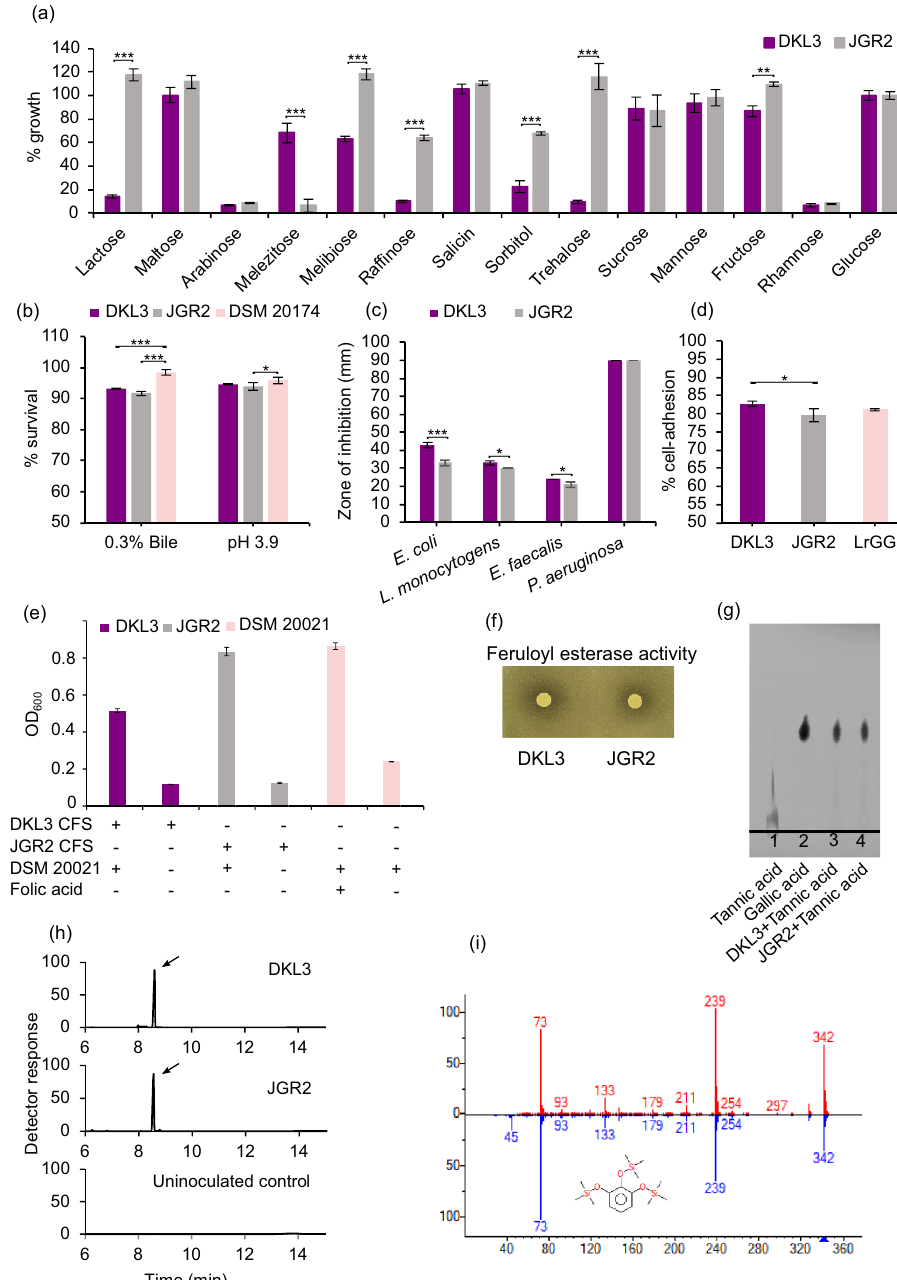
Figure 2. Phenotypic characterization of L. plantarum DKL3 and JGR2. ( a ) Sugar utilization. Values denoted are percentage as compared to glucose. ( b ) Bile and low pH survival. ( c ) Antimicrobial activity against various pathogens. ( d ) Adhesion to the HT-29 cell line. ( e ) Folate production as assessed by the growth of L. rhamnosus DSM 20021 in folic acid deficient medium supplemented with cell-free supernatant (CFS) of DKL3 and JGR2. ( f ) Feruloyl esterase activity as seen as the zone of clearance surrounding the growth of the strains in mMRS agar containing ethyl ferulate ( g ) Tannase activity as assessed by TLC of the products formed upon incubating the strains with tannic acid. ( h ) Gallate decarboxylase activity as assessed by GC–MS analysis of the TMS- derivatized reaction products formed upon incubating the strains with gallic acid. 3TMS-pyrogallol peak is indicated by the arrows in the total ion chromatograms. The mass spectrum of the 3TMS-pyrogallol peak in ( h ) is indicated in top-panel of ( i ) whereas the bottom panel represents 3TMS-pyrogallol spectrum in the mass spectral library. All values are mean of triplicates and error bars denote standard deviation. Asterisks denote the values which are significantly different from each other as determined by unpaired Student’s t-test for a and c and two-way ANOVA for ( b ) and ( d ) ( p ≤ 0.05, *; p ≤ 0.01, **; p ≤ 0.001,